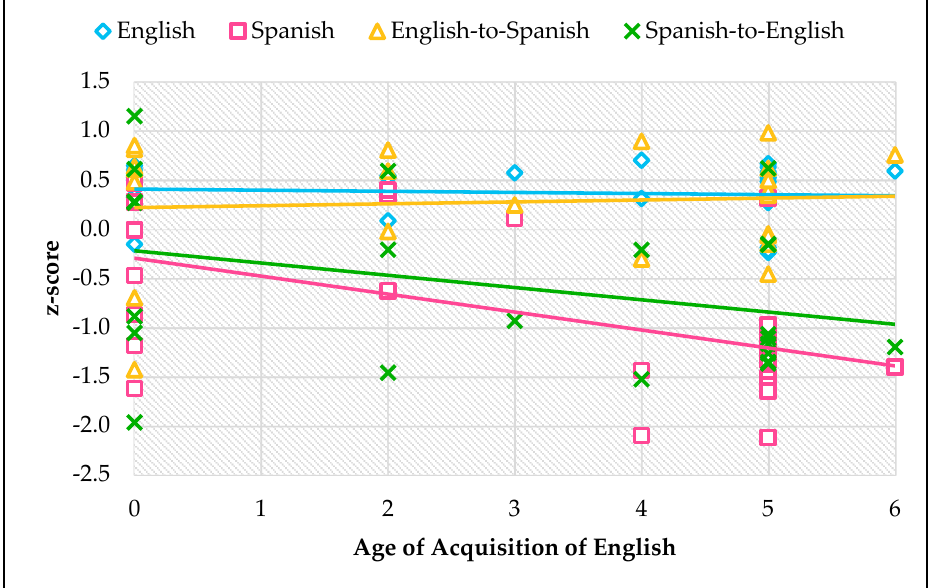
Figure 3. Average z-score by language(s) and AoA of English.